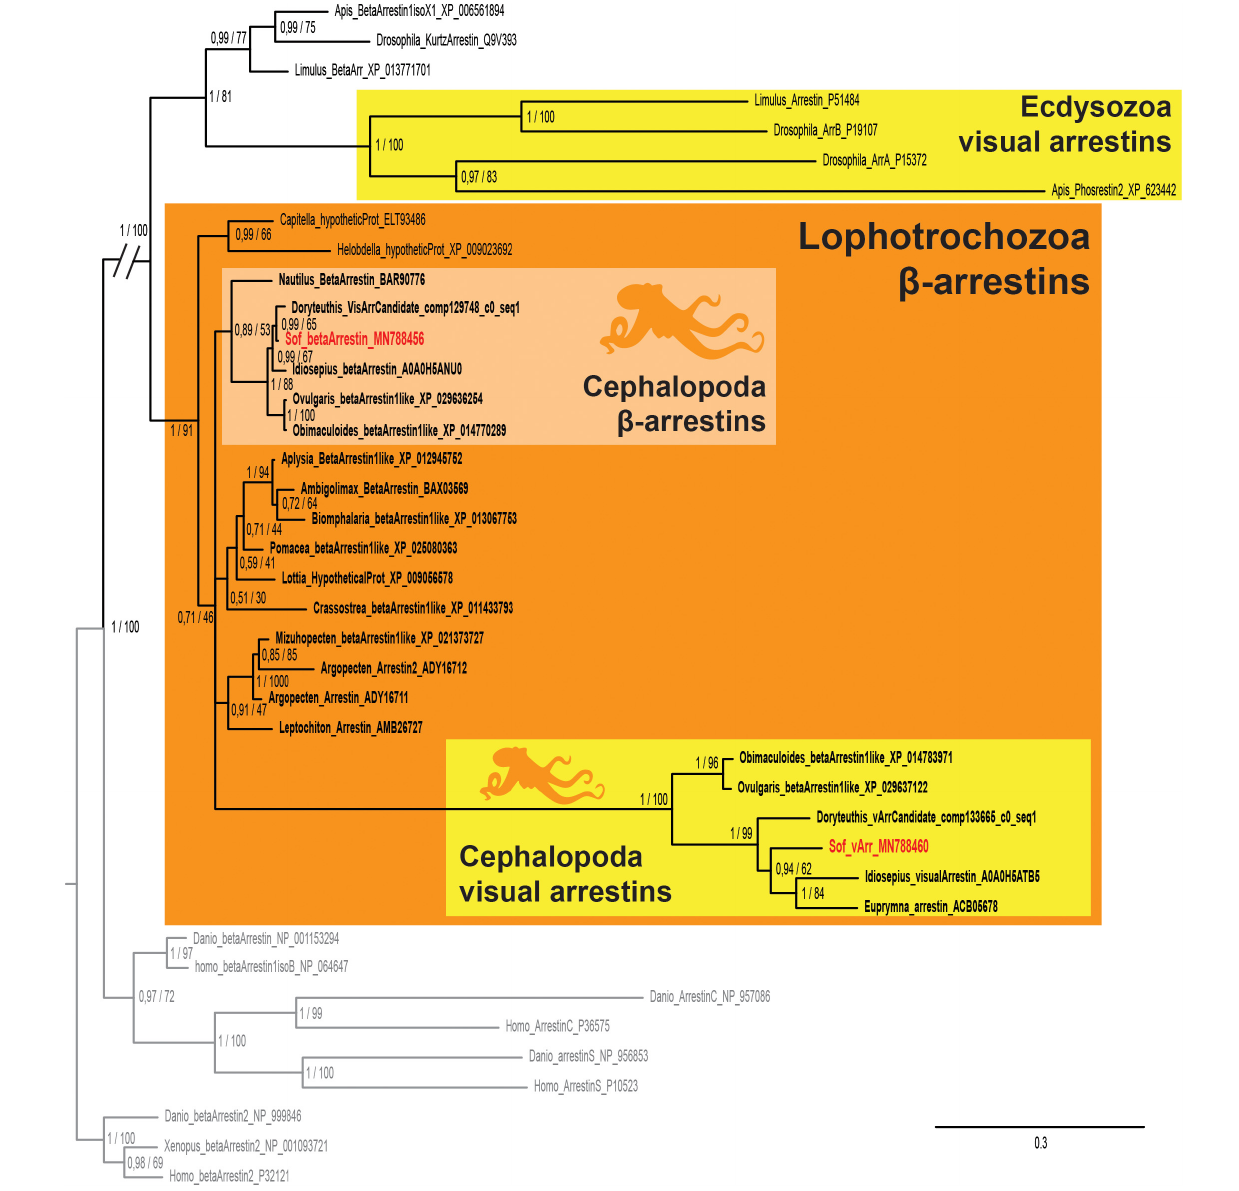
Frontiers in Physiology |